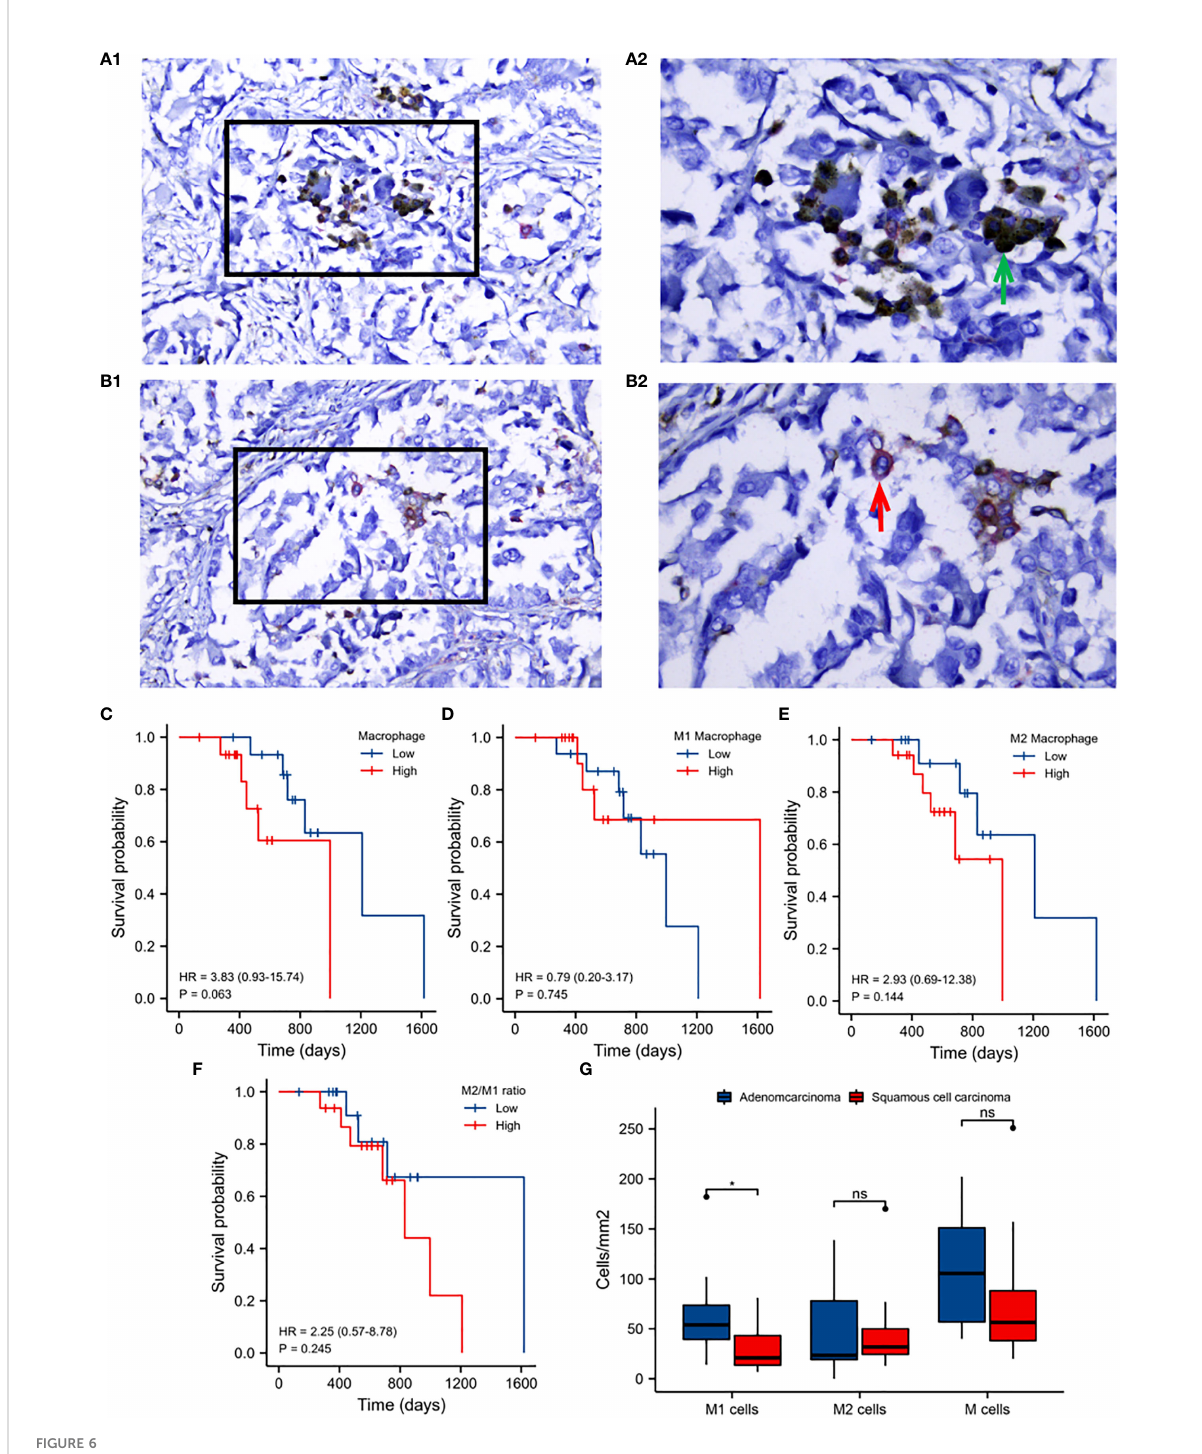
FIGURE 6 Validation analysis of clinical samples. A1: Immunohistochemical staining of M1 macrophages. A2: Enlargement of the boxed regions. B1: Immunohistochemical staining of M2 macrophages. B2: Enlargement of the boxed regions. Images were obtained at 40×10 magni fi cation under a light microscope. (C) Kaplan-Meier survival analysis of macrophage in fi ltration. (D) M1 macrophage in fi ltration. (E) M2 macrophage in fi ltration. (F) M2 to M1 macrophage in fi ltration. (G) M1, M2 and total macrophage in fi ltration between adenocarcinoma and squamous cell carcinoma. Horizontal axis: survival time. Vertical axis: survival probability. Colors: macrophage in fi